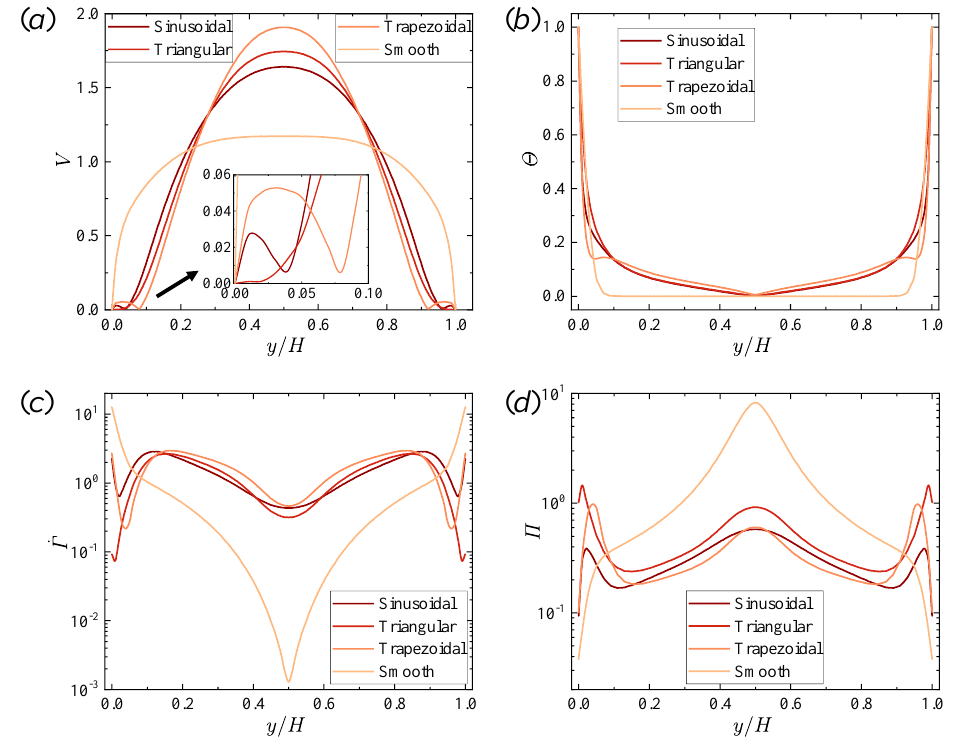
Figure 8. Profiles of the dimensionless ( a ) velocity, ( b ) temperature, ( c ) shear rate and ( d ) viscosity in the transverse direction at the outlet of the test section for smooth channel and channel with different corrugation profiles. The geometry and the flow conditions are listed in Table 3.